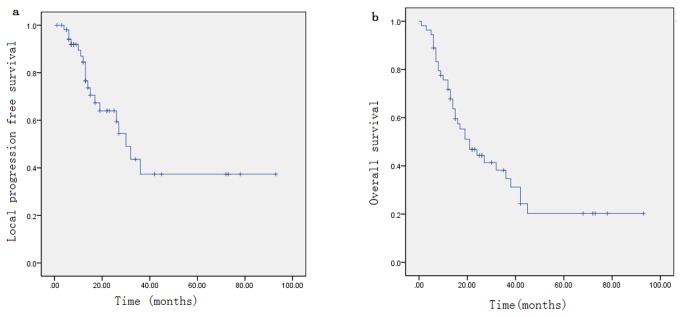
Kaplan-Meier curves showing local progression-free survival (a), overall survival (b)